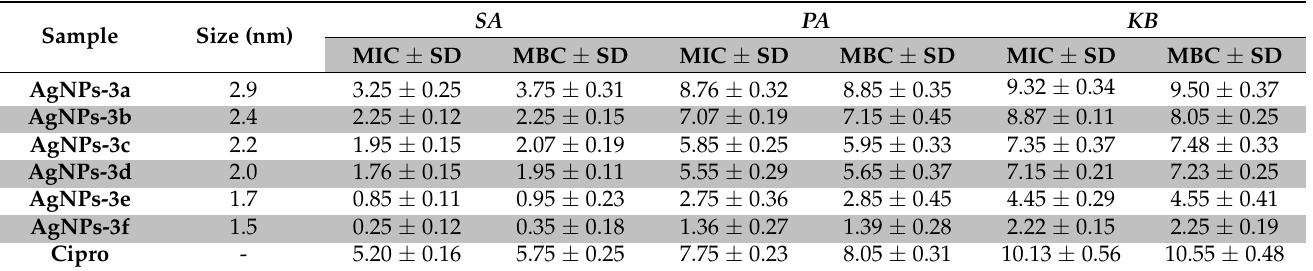
Table 2. MIC and MBC values ( µ g/mL) of new BAIILs-supported AgNPs against ESKAPE pathogens, as compared to clinical antibiotics (GM and